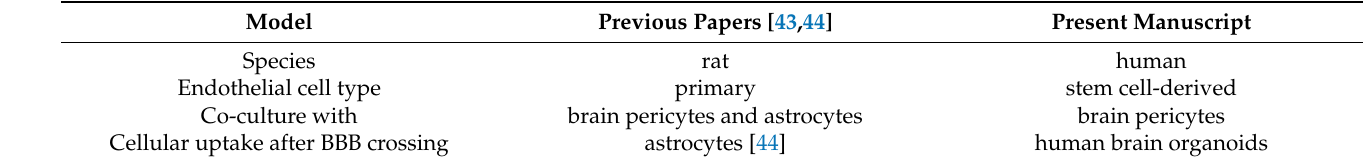
Table 3. Main differences between the cell culture models in our previous works [43,44] and the present